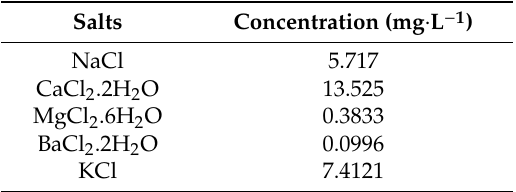
Table 1. Synthetic brine formulation resembling the salt composition of the on-site injected